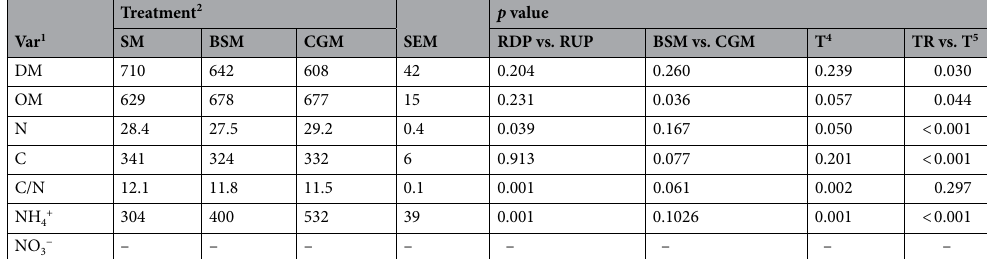
Table 3. Chemical composition of the manure, deposited in the soil, of Nellore cattle fed with sources of rumen undegradable protein during the finishing phase in feedlot. 1 DM = dry matter (g kg −1 ), OM =